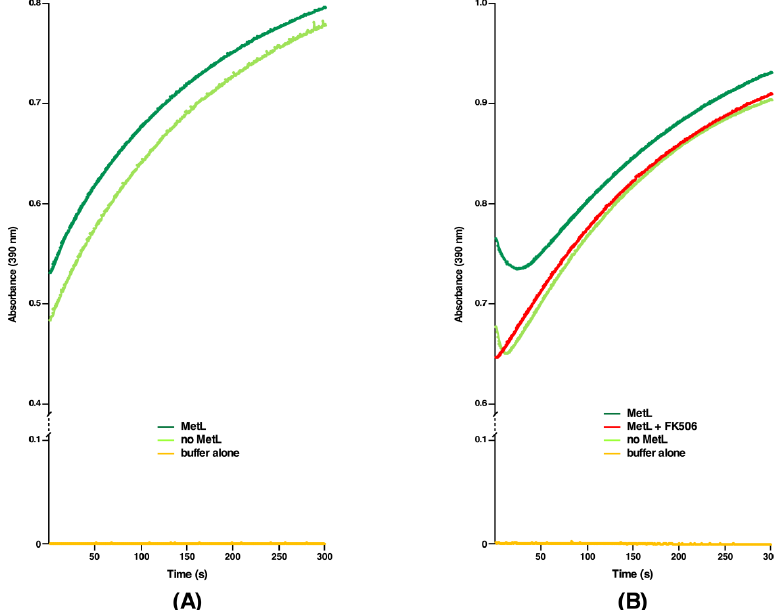
Figure 7. Multicopy suppressor of Δ 6 ppi the cytidylate kinase Cmk exhibits the PPIase activity. ( A ) Measurement of PPIase activity of Cmk in the chymotrypsin-coupled assay, using 5 μ M of protein in the assay buffer. ( B ) Measurement of inhibition of the PPIase activity of Cmk by the two-fold molar excess of FK506. The PPIase activity in the presence or absence of FK506 and the uncatalyzed reaction without any enzyme are plotted in the light violet color. Int. J. Mol. Sci. 2020 , 21 , x FOR PEER REVIEW